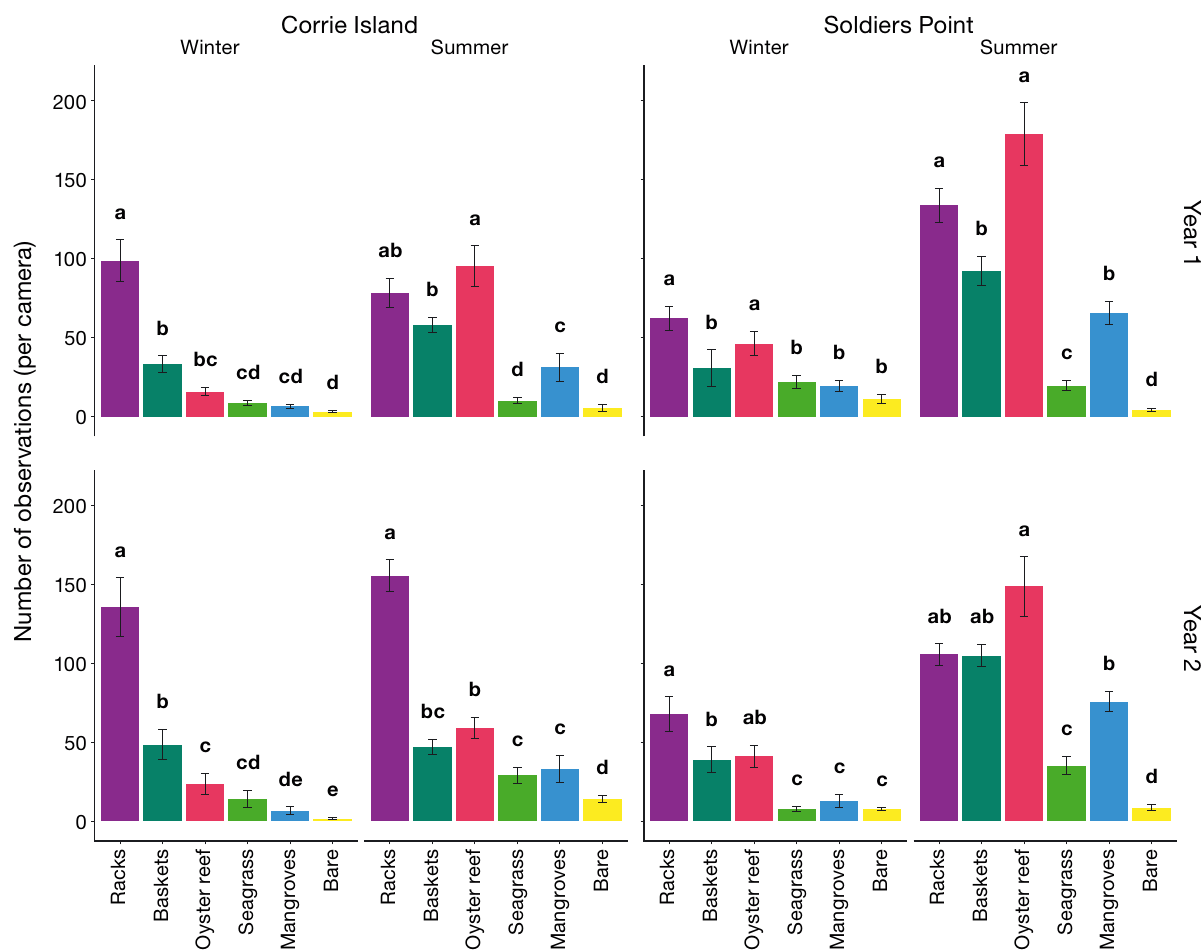
Fig. 4. Mean (±SE) fish observations, per habitat site, season and year as documented by 75 min remote underwater video de- ployments (n = 48). Letters above columns denote treatments that were significantly different (at α = 0.05) within each year, site and season by estimated marginal means